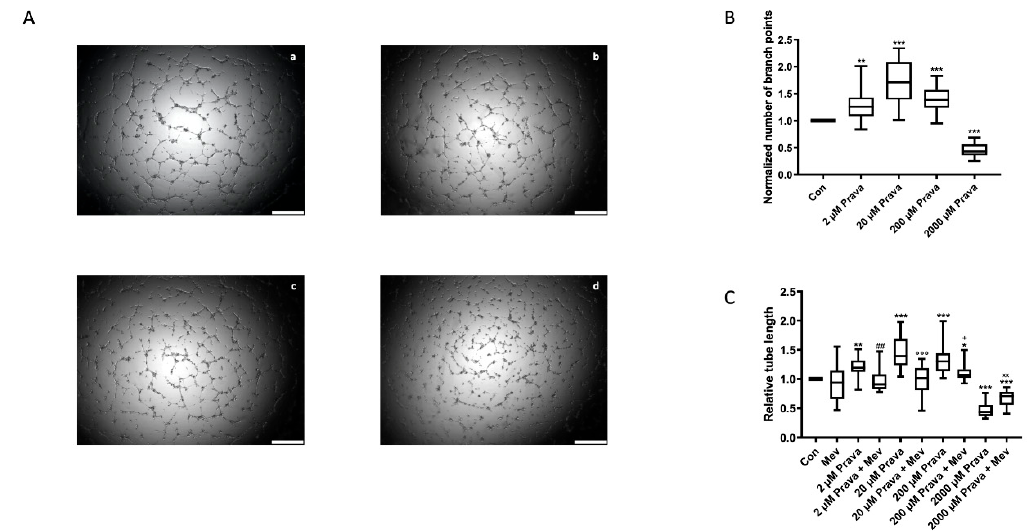
Figure 2. Pravastatin enhanced ECFCs’ angiogenesis. ( A ) Representative images from ECFCs treated with medium only (a), 20 μ M (b), 200 μ M (c) or 2000 μ M (d) pravastatin for 6 h, scale bar 500 μ m. ( B ) Pravastatin treatment (2, 20 and 200 μ M) led to a higher number of branching points in ECFCs after 6 h of incubation. A total of 2000 μ M pravastatin, in contrast, reduced the number of branch points. ( C ) Pravastatin treatment (2, 20 and 200 μ M) of ECFCs significantly increased tube length after 6 h of incubation, whereas 2000 μ M pravastatin significantly impaired tube formation ability. Mevalonate (200 μ M) did not affect tube formation ability in ECFCs but diminished pravastatin induced effects. In comparison to pravastatin treatment, only tube length was significantly less after pravastatin (2 μ M, 20 μ M and 200 μ M) treatment in the presence of mevalonate. Mevalonate (200 μ M) also attenuated the inhibitory effect on tube formation of high ‐ dose pravastatin (2000 μ M). Additional representative images of combined treatment can be found in Supplemental Figure S2. n = 12. Con, control; Prava, pravastatin; Mev, mevalonate. * p < 0.05, ** p < 0.01, *** p < 0.001 compared to control, ## p < 0.01 compared to 2 μ M Prava, °°° p < 0.001 compared to 20 μ M pravastatin, + p < 0.05 compared to 200 μ M pravastatin, xx p < 0.01 compared to 2000 μ M pravastatin; control group set as 1.